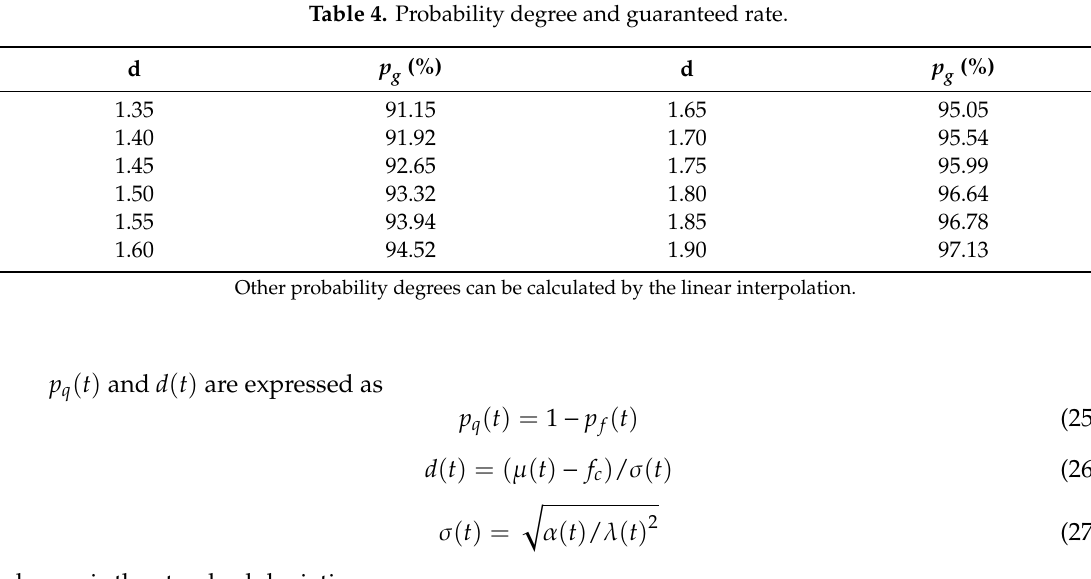
Figure 17. Normal distribution of